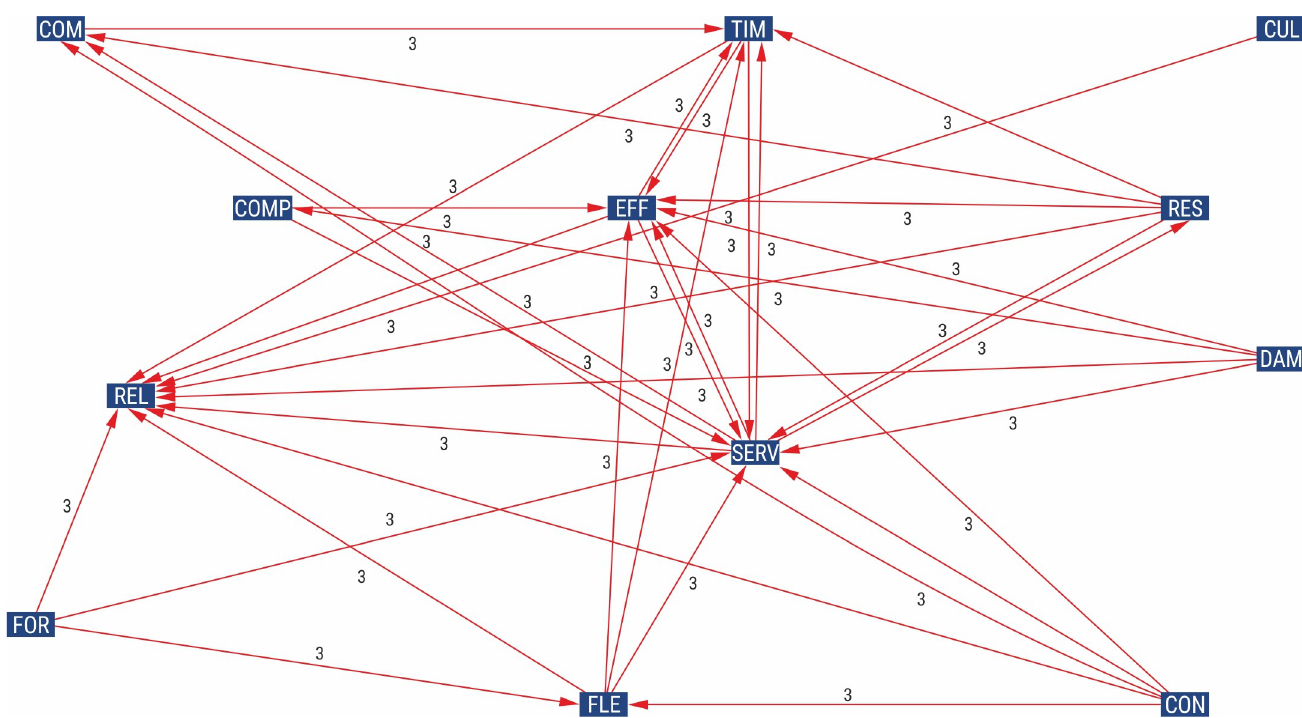
Fig 2. Direct impact graph. Source: Own